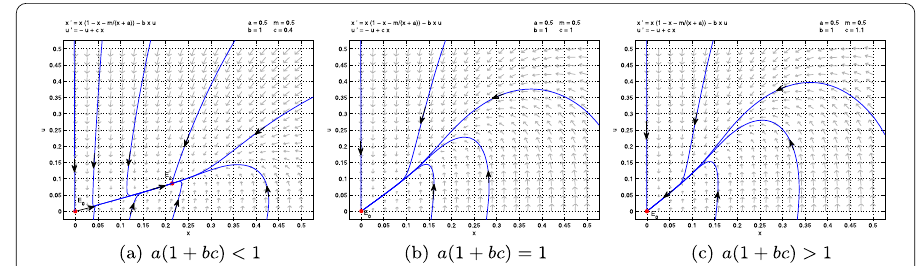
Figure 3 The phase portraits of system (1.6) when m = a : ( a ) Two equilibria E 0 and E 2 . E 0 is a saddle-node and E 2 is a stable node. ( b ), ( c ) A trivial equilibrium E 0 which is a